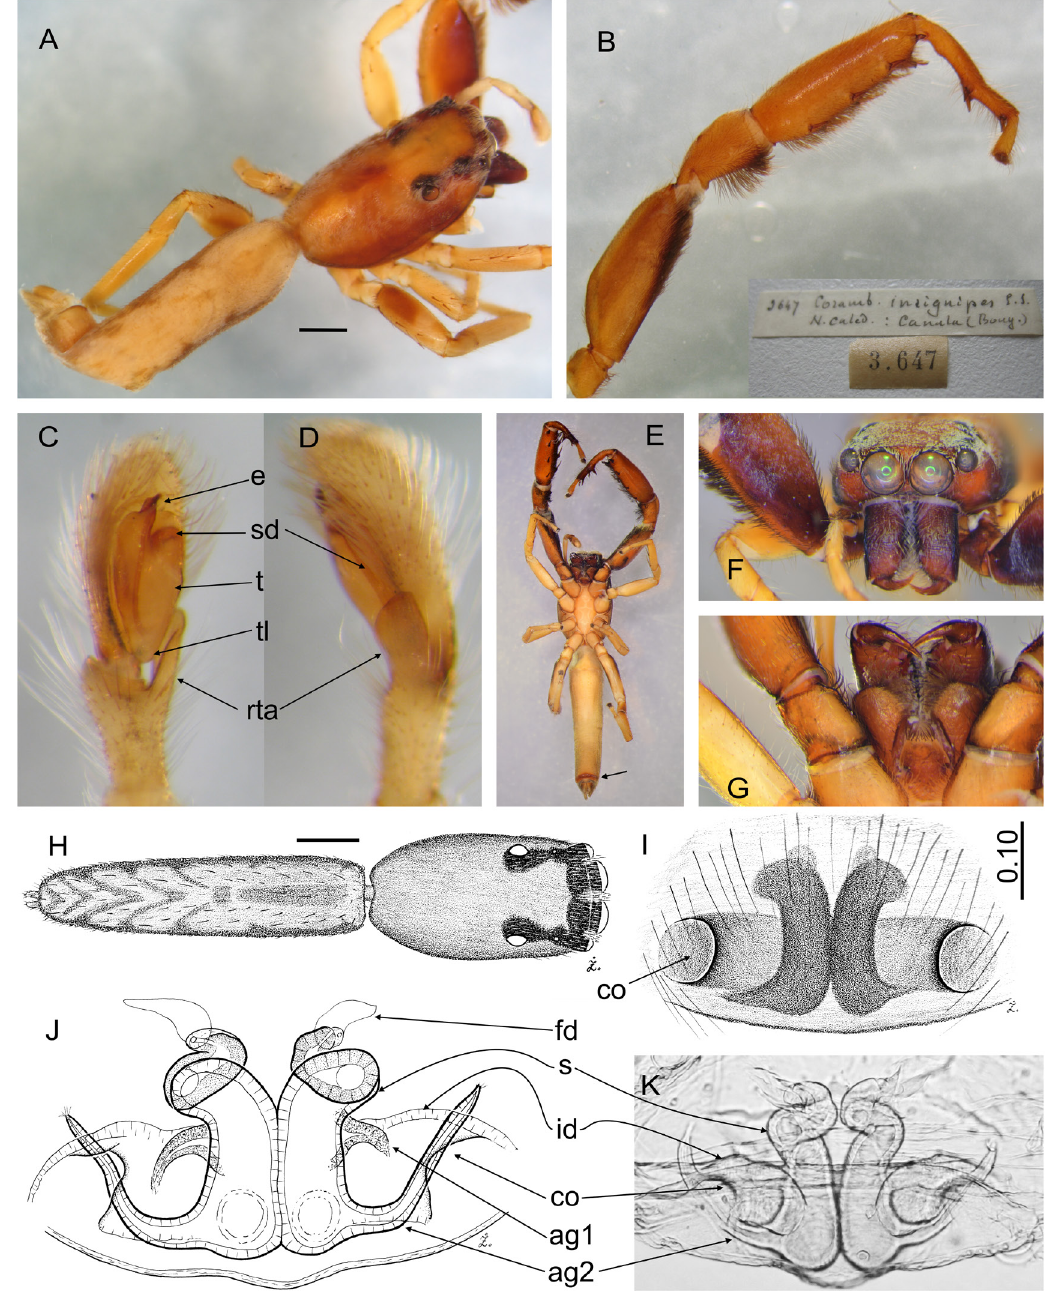
Fig. 2. Corambis insignipes (Simon, 1880). A–D. MNHN 2647. E–G. QMB 11483. H–K. Vallee Tionaka (MNHN). A, E – F . Dorsal, ventral and frontal views, ♂. B . First leg, ♂. C – D . Palpal organ, ♂. G . Chelicerae, maxillae and labium, ♂. H . Dorsal view, ♀. I . Epigyne, ♀. J–K . Internal genitalia, ♀. Scale bars: A, H = 1